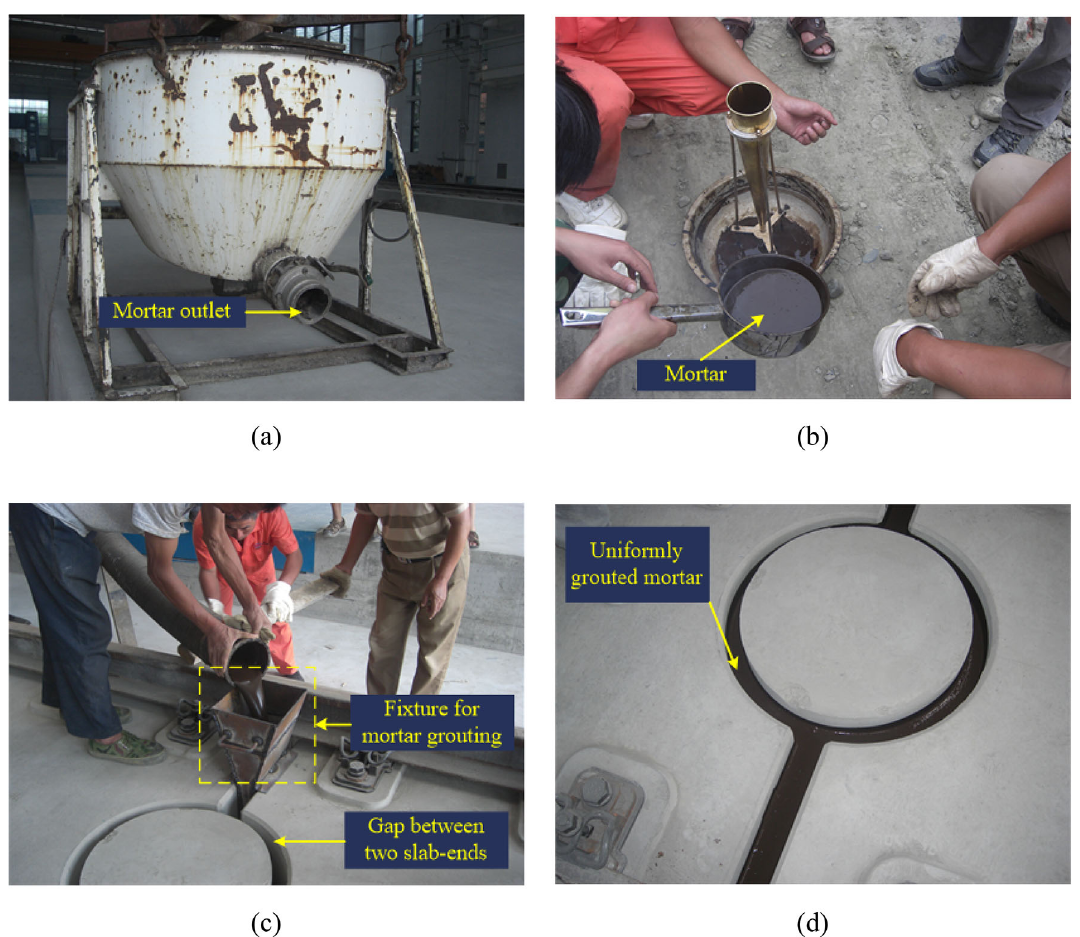
Fig. 8 Mortar grouting process for the CRTS I slab track system: a mortar mill; b evaluation of milled mortar; c mortar grouting; d uniformly grouted